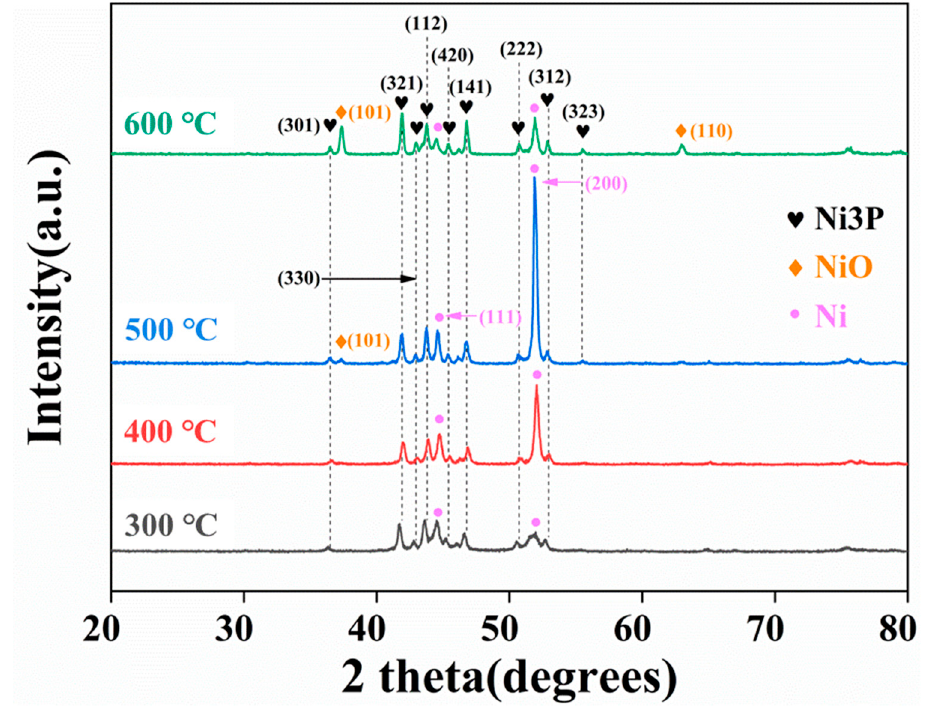
Figure 6. XRD of Ni-P-CS treated at different temperatures.